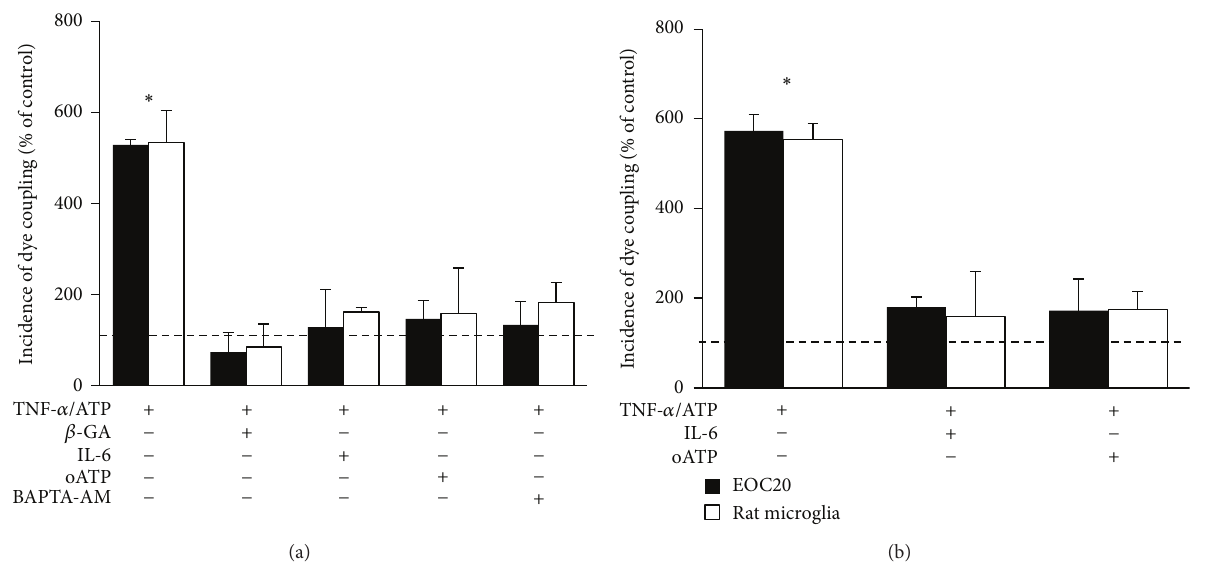
Figure 2: IL-6, intracellular calcium chelation, and P2X inhibition prevent the induction of gap junctional communication promoted by TNF- 𝛼 plus ATP or TNF- 𝛼 /IFN- 𝛾 . (a) Graph showing the effect of acutely applied 50 𝜇 M 18- 𝛽 -glycyrrhetinic acid ( 𝛽 -GA) or pretreatment with 10ng/mL interleukin-6 (IL-6), 300 𝜇 M oxidized ATP (oATP), or 10 𝜇 M BAPTA-AM on the incidence of dye coupling (IDC) of microglia treated for 3.5 h with TNF- 𝛼 plus ATP. (b) Graph showing the effect of 50 ng/mL IL-6 or 300 𝜇 M oATP over the IDC of microglia treated for 9h with TNF- 𝛼 /IFN- 𝛾 . Data is expressed as a percentage of IDC under control conditions (dashed line). ∗ 𝑃 < 0.05 versus control condition. Each bar represents the mean ± SEM, 𝑛 = 5 . No significant differences were observed when comparing microglia and EOC20 cells responses to different treatment in dye transfer